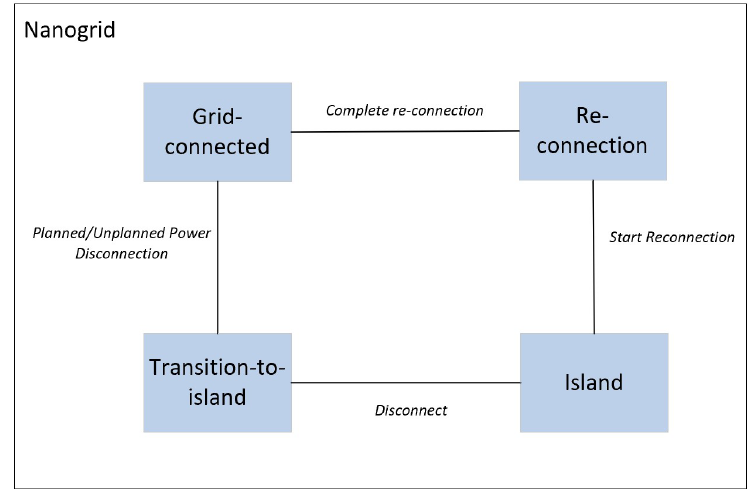
Figure 4. Microgrid and Nanogrid Operating Modes [2]. The figure shows how a microgrid or nanogrids can move between different modes of operation.